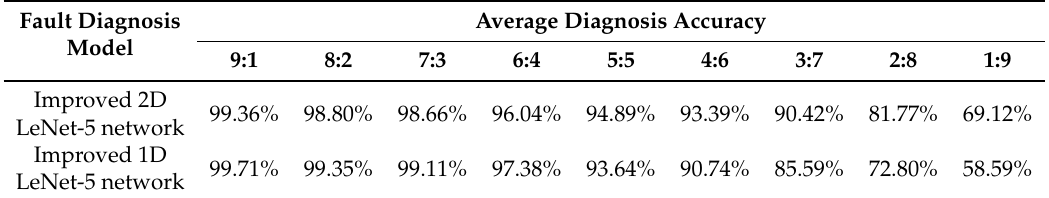
Table 8. Average Diagnosis accuracy obtained under different ratios of training set to test